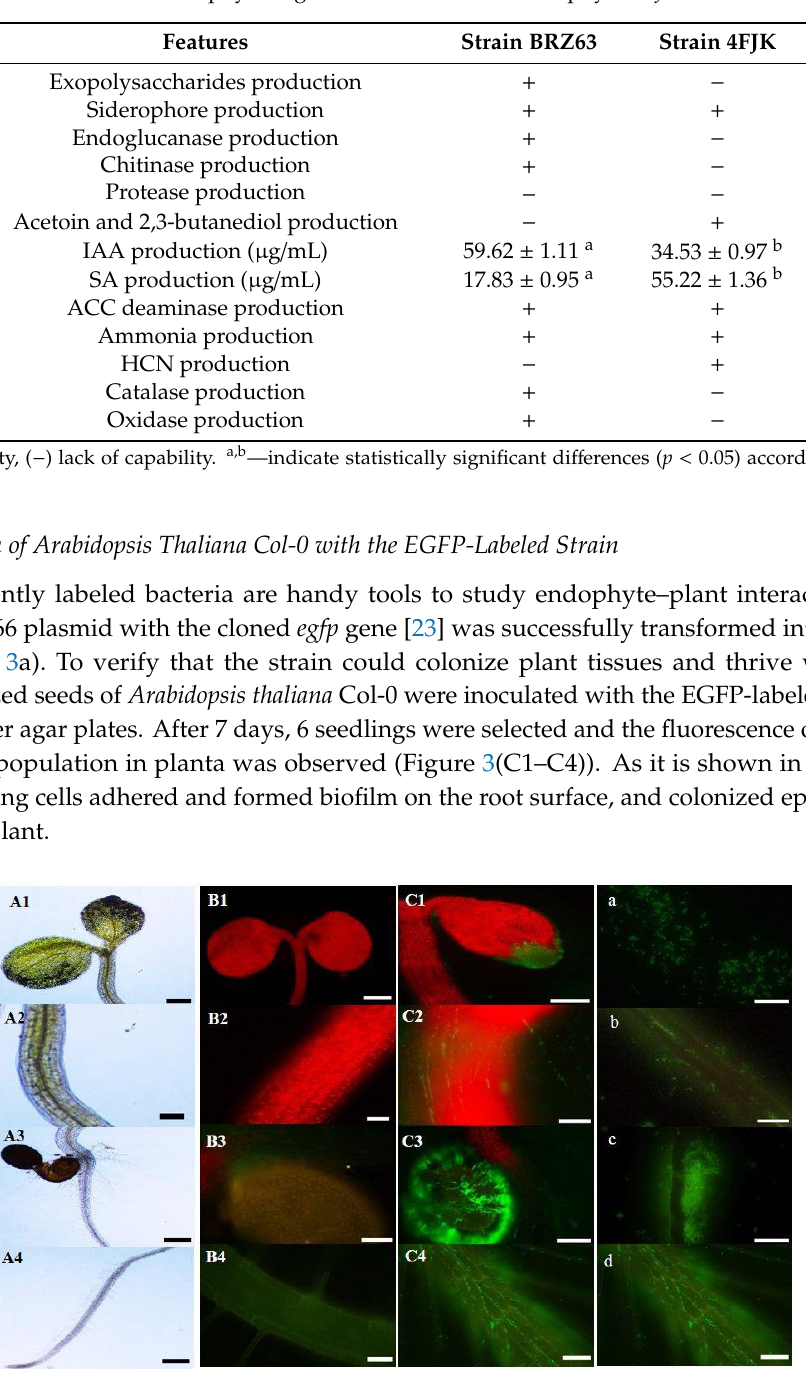
Figure 3. The colonization of Arabidopsis thaliana Col-0 and stages of the plant roots colonization with the EGFP-labeled BRZ63 strain. Uninoculated plant observed under a light microscope ( A1 – A4 ) (scale bar: A1 = 200 µ m, A2 = 100 µ m, A3 = 200 µ m, A4 = 200 µ m). Uninoculated plant ( B1 – B4 ) (scale bar: B1 = 100 µ m, B2 = 100 µ m, B3 = 100 µ m, B4 = 40 µ m, and plant after inoculation with EGFP-labeled BRZ63 strain ( C1 – C4 ) (scale bar: C1 = 200 µ m, C2 = 50 µ m, C3 = 200 µ m, C4 = 20 µ m observed with a Nikon ECLIPSE-Ni-U stereo microscope equipped with epifluorescence detection. EGFP-labeled cells of BRZ63 (scale bar = 10 µ m) ( a ), adhesion of bacteria to the root surface and the root hairs (scale bar = 20 µ m) ( b ), biofilm formation (scale bar = 20 µ m) ( c ), colonization of epidermal cells (scale bar = 20 µ m) ( d ). All pictures were processed using ImageJ